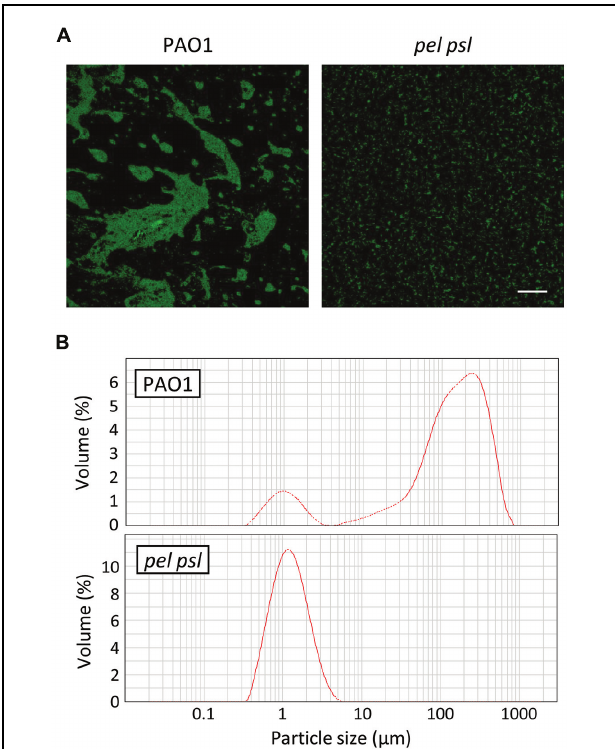
FIGURE 3 | Role of Pel and Psl exopolysaccharides in planktonic aggregation of P. aeruginosa cells. (A) Confocal microscopy images of P. aeruginosa PAO1 and pel psl cells harboring the GFP-expressing vector pMMG cultured in TSBD at 37 ◦ C under static conditions for 14 h. The images are representative of several micrographs from five independent experiments. Bar: 50 μ m. (B) Representative laser diffraction analysis (LDA) particle-size scans of P. aeruginosa PAO1 and pel psl liquid cultures in TSBD after 14 h of growth at 37 ◦